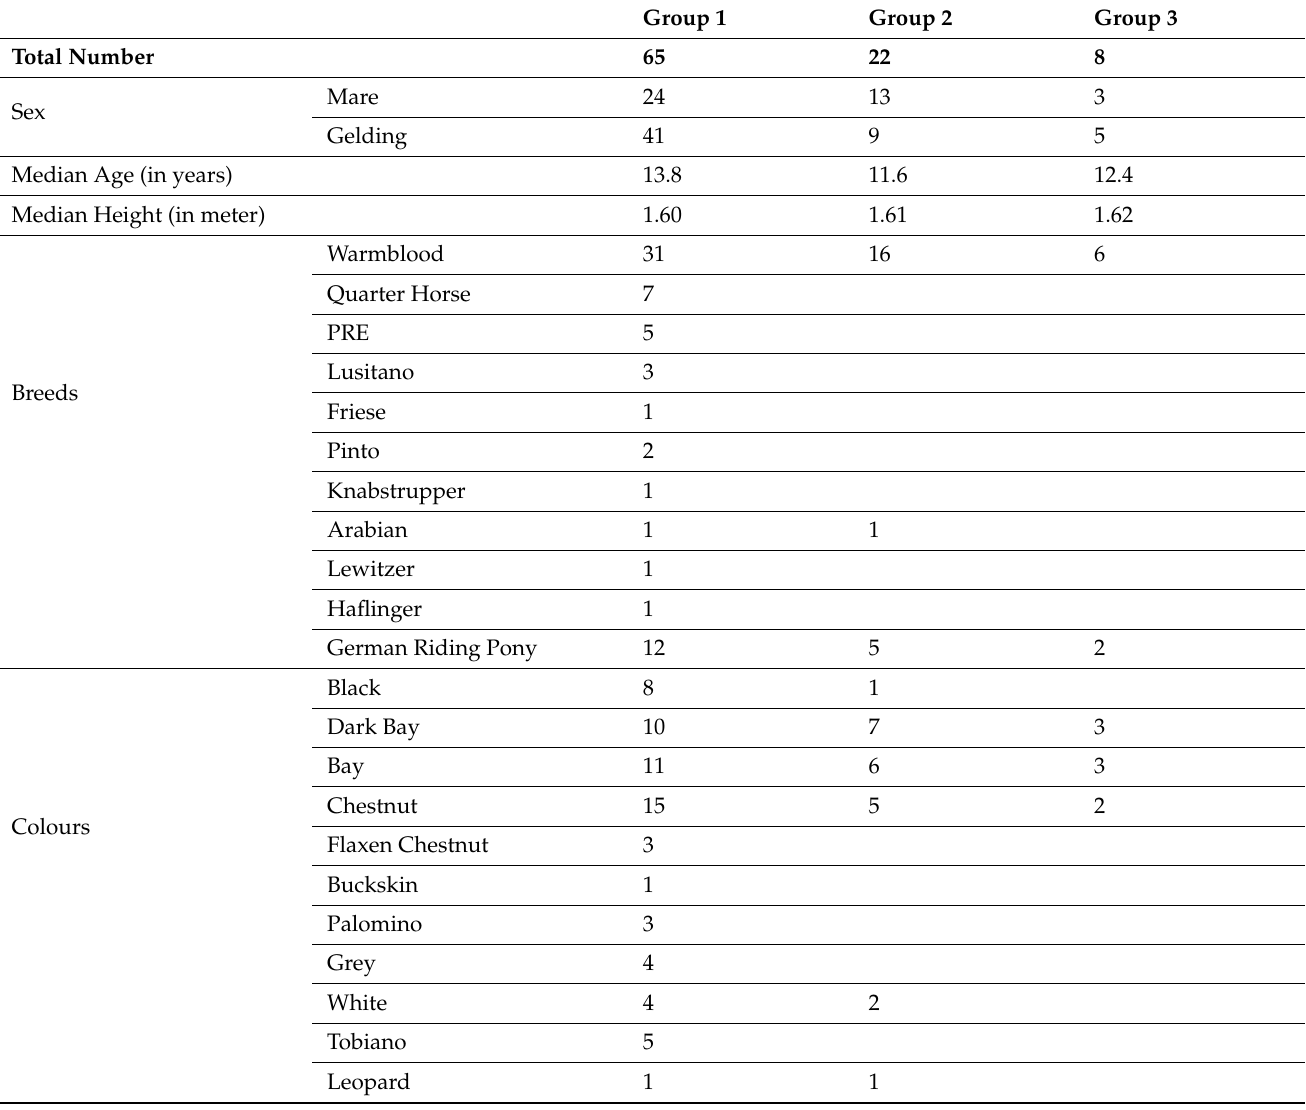
Table A2. Horses of Groups 1–3 (classified into sex, median age, median height, breed and colour).